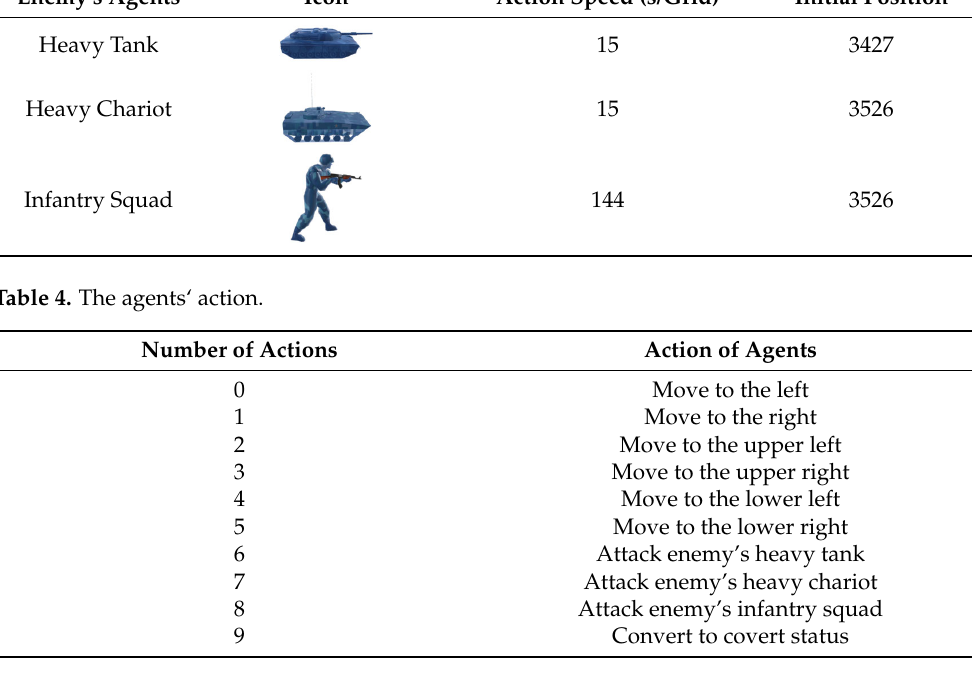
Table 3. The enemy’s agents and their details.